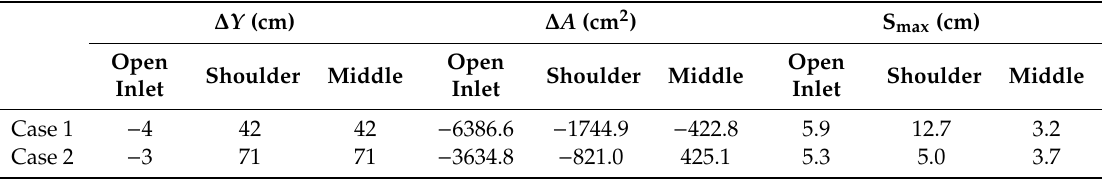
Figure 10. Morphological changes in each cross-section by structure type (Case 1: dolos; Case 2: hybrid (dolos with the coral reef)): ( a ) cross-section change at the open inlet (section A) with only the submerged breakwater (Case 1), ( b ) cross-section change at the open inlet (section A) with the hybrid method (Case 2), ( c ) cross-section change at the shoulder of the structure (section B) with only the submerged breakwater (Case 1), ( d ) cross-section change at the shoulder of the structure (section B) with the hybrid method (Case 2), ( e ) cross-section change at the middle of the structure (section C) with only the submerged breakwater (Case 1), and ( f ) cross-section change at the middle of the structure (section C) with the hybrid method (Case 2). Table 3. Morphological changes dependent on the structure